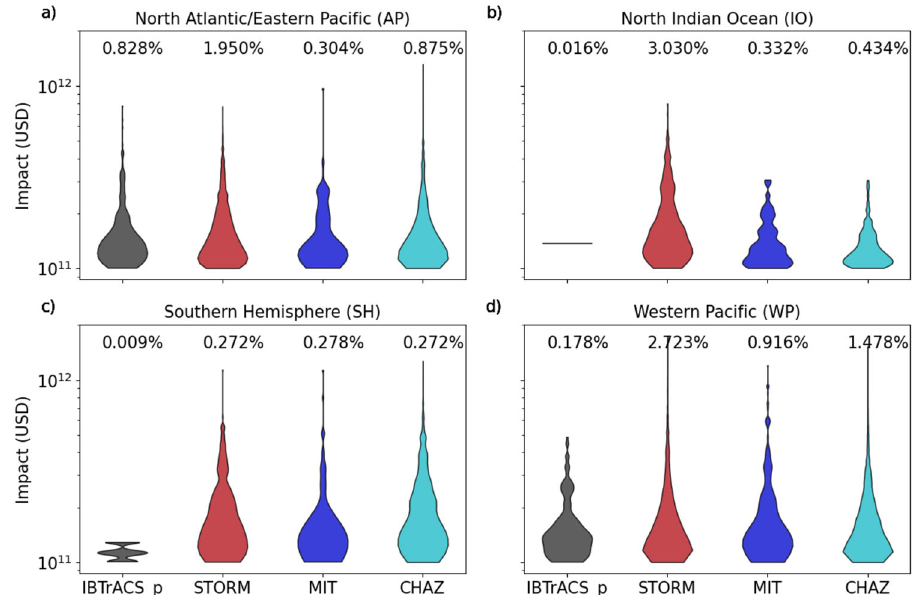
Fig. 3 | Tail risk assessment of the synthetic tropical cyclone datasets across regions. Probability density of impacts exceeding the 100 billion USD impact for the four synthetic datasets (IBTrACS_p, STORM, MIT, CHAZ) in our four study regions a North Atlantic/Eastern Paci fi c, b North Indian Ocean, c Southern Hemi- sphere, d Western Paci fi c). Percentages printed above each probability density indicate the fraction of all impacts in the corresponding dataset above the